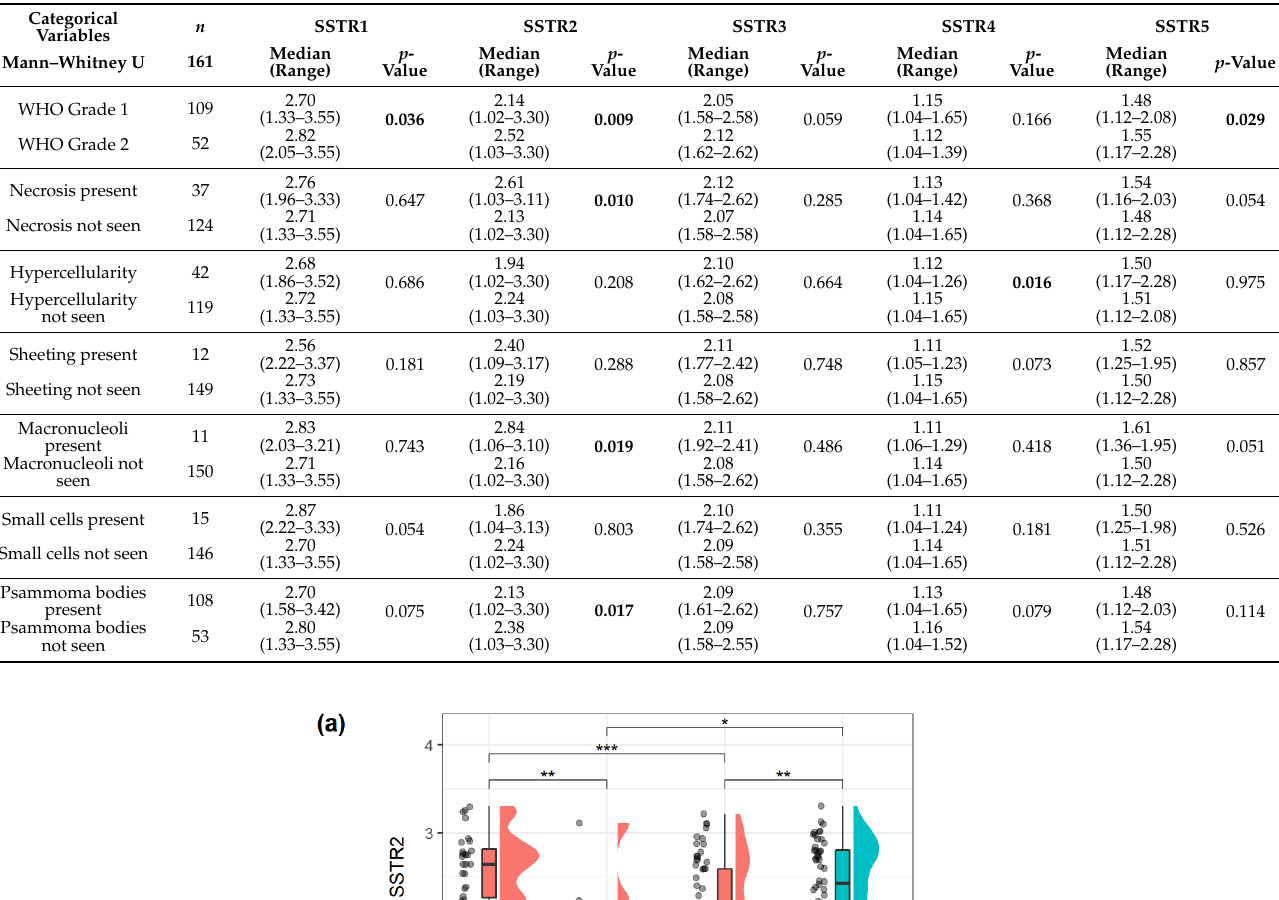
Table 4. SSTRs expression, using digital scoring, in relation to dichotomic histological features. p -values from two-tailed exact values Mann-Whitney U test with significant results in bold.